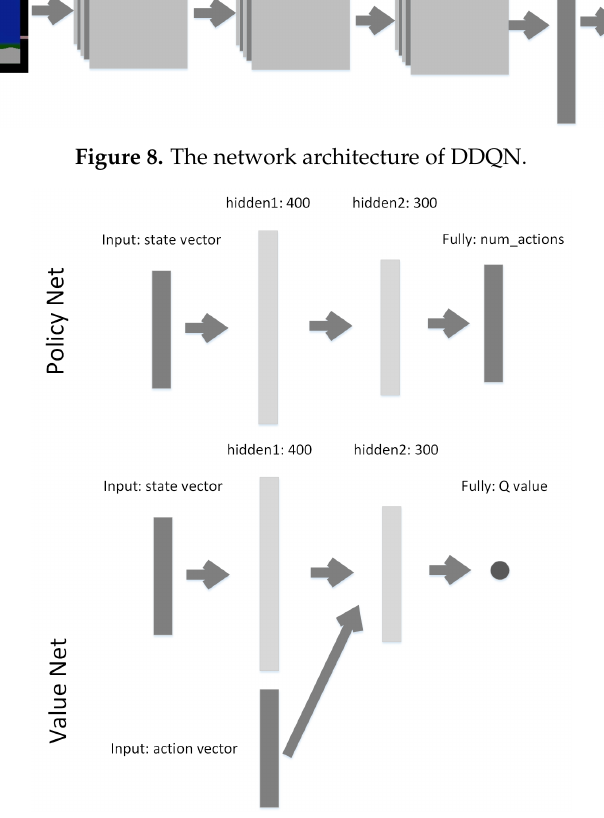
Figure 9. The network architecture of